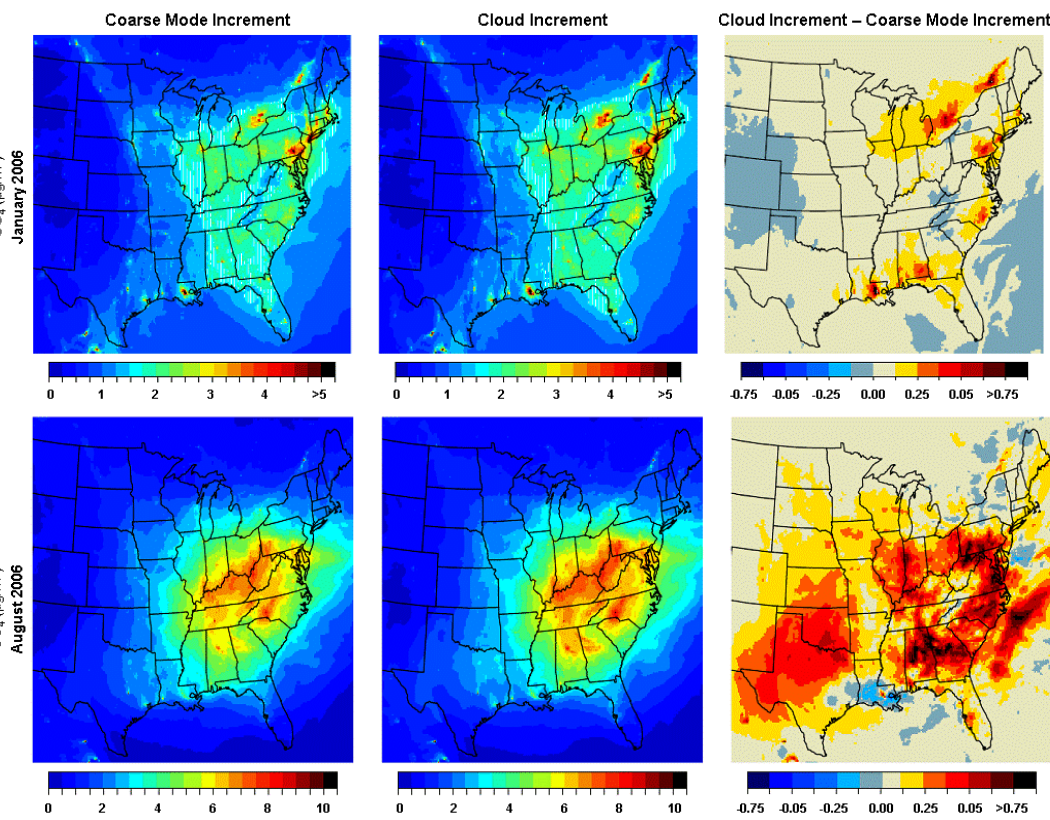
Fig. 7. Monthly average SO 2 − concentrations (µg/m 3 ) for January (top row) and August (bottom row) 2006 for the previous model (left 4 column), revised model (middle column) and their difference (right